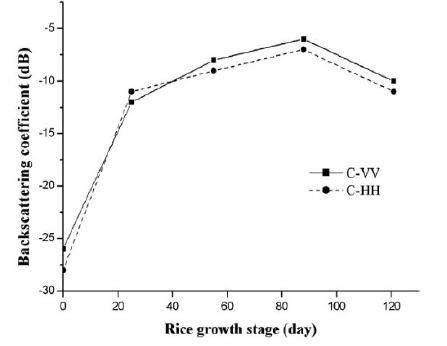
Fig.3: Variation of backscattering coefficients with rice-crop- biomass